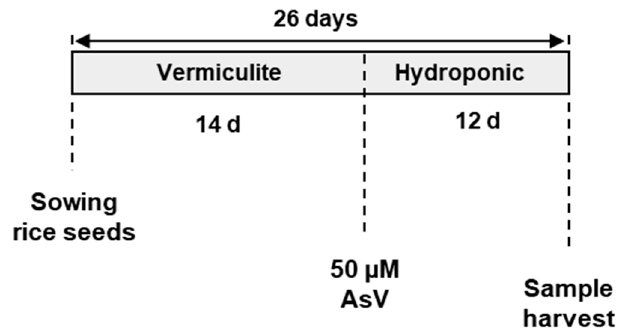
Figure 1. Experimental design of the arsenate effect on 26-d-old rice seedlings grown in hydroponic solutions supplemented the last 12 days with 50 µ M arsenate (AsV).